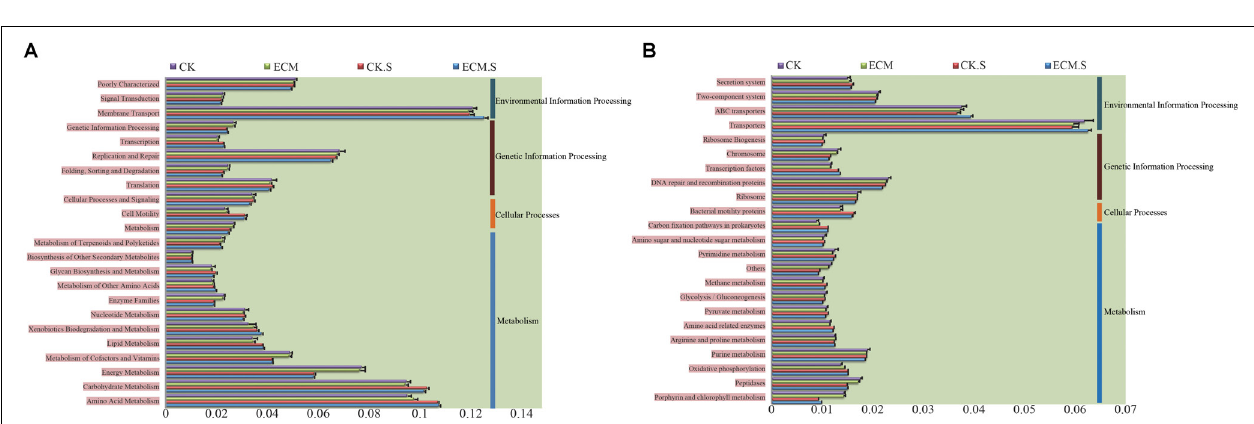
FIGURE 4 | Non-metric multidimensional scaling (NMDS) analysis of bacterial (A) and fungal (B) communities in Q. aliena roots and the surrounding soil and with or without T. indicum partner. ECM, ectomycorrhizae; ECM.S, ectomycorrhizosphere soil; CK, roots of Q. aliena without T. indicum partner; CK.S, rhizosphere soil of Q. aliena without T. indicum partner.